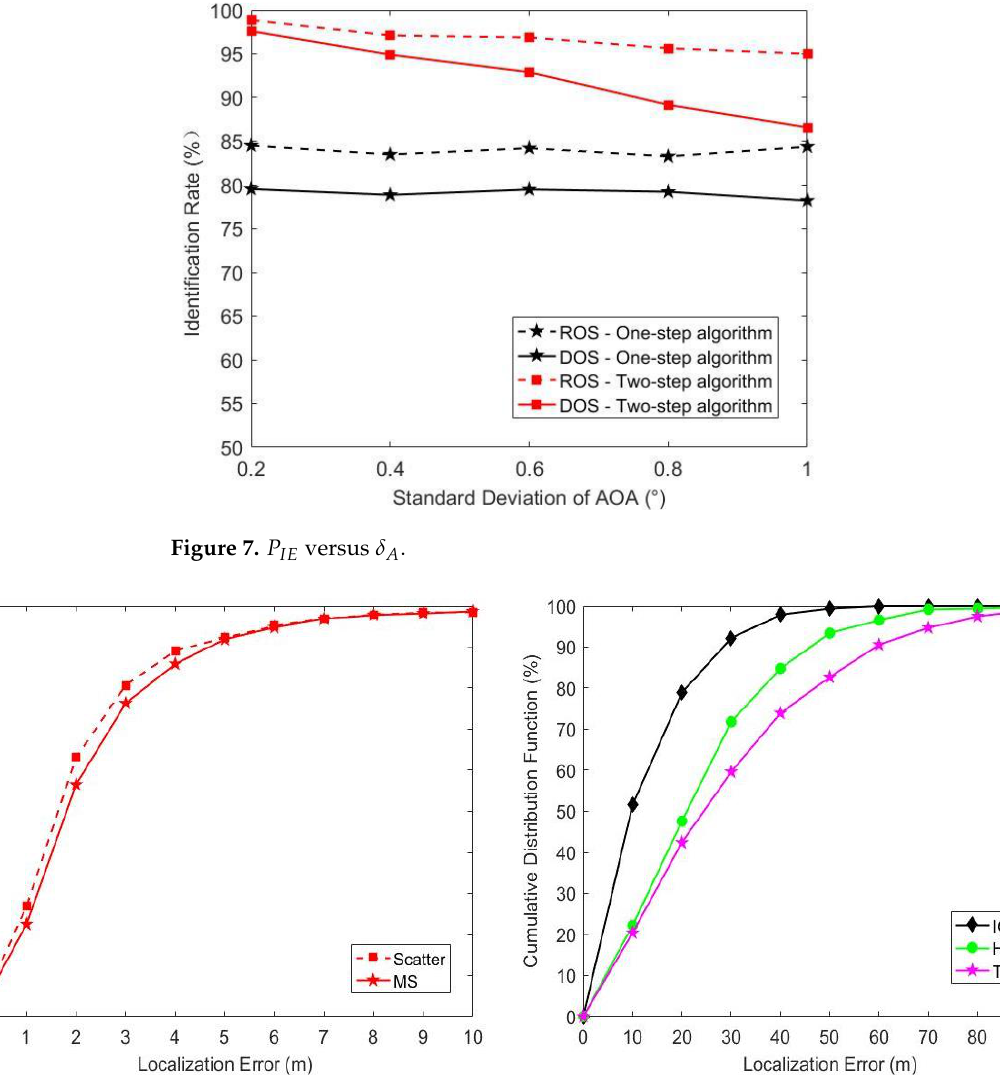
( b ) Figure 9. Localization error CDFs curve for ROS model. ( a ) The curve of proposed algorithm; ( b ) The curve of IGSA, HTA and NTA-CA. In the proposed localization algorithm, the MS localization is based on the scatterer localization, the localization error of the scatterer will propagate to the procedure of MS localization. The MS localization error can be divided into two parts: the localization error